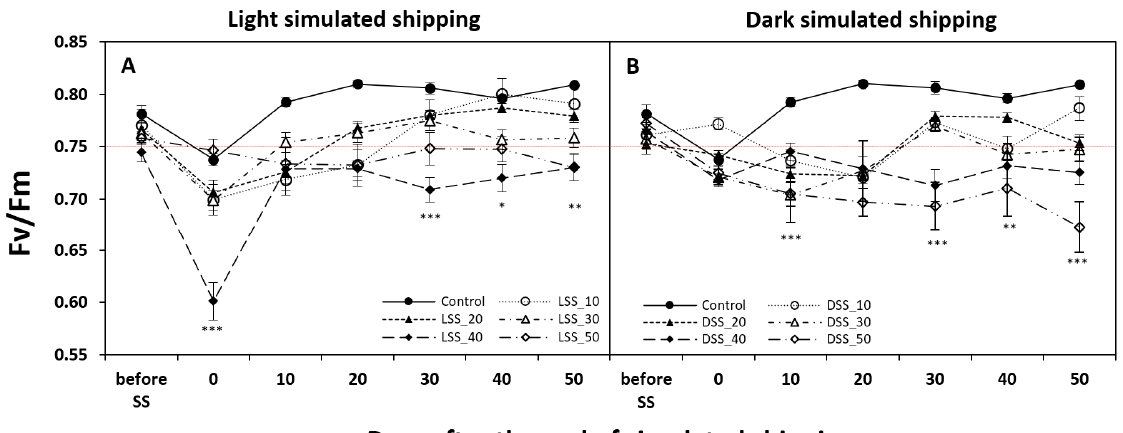
Figure 6. Changes in Fv/Fm according to time before and after the end of light ( A ) and dark ( B ) simulated shipping (day 0) as influenced by simulated shipping duration in Phalaenopsis Sogo Yukidian ‘V3’. Red line represents the optimal level (0.75–0.85) for non-stressed plants [25]. *, **, *** Significant at p ≤ 0.05, 0.01, or 0.001, respectively.